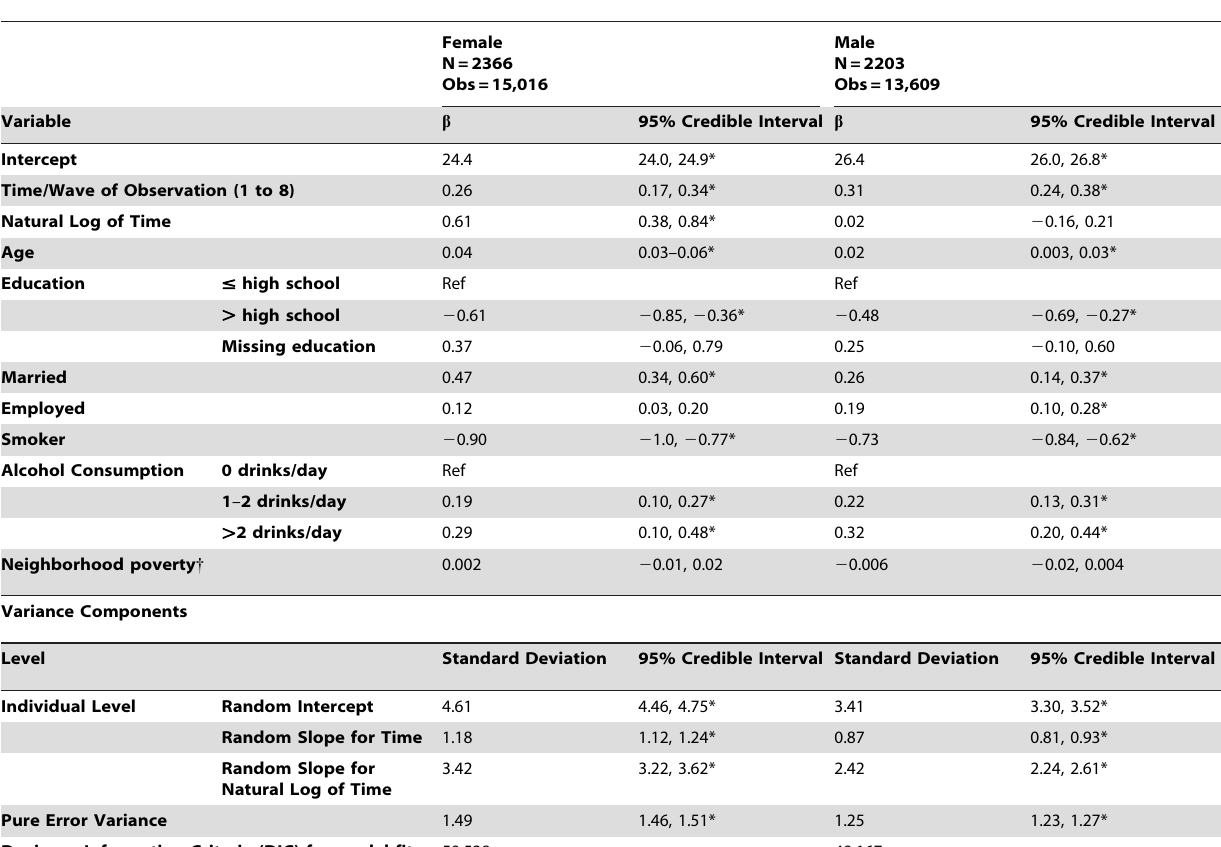
Table 2. Parameter Estimates from Final Models, Framingham Heart Study Offspring Cohort, 1971 to